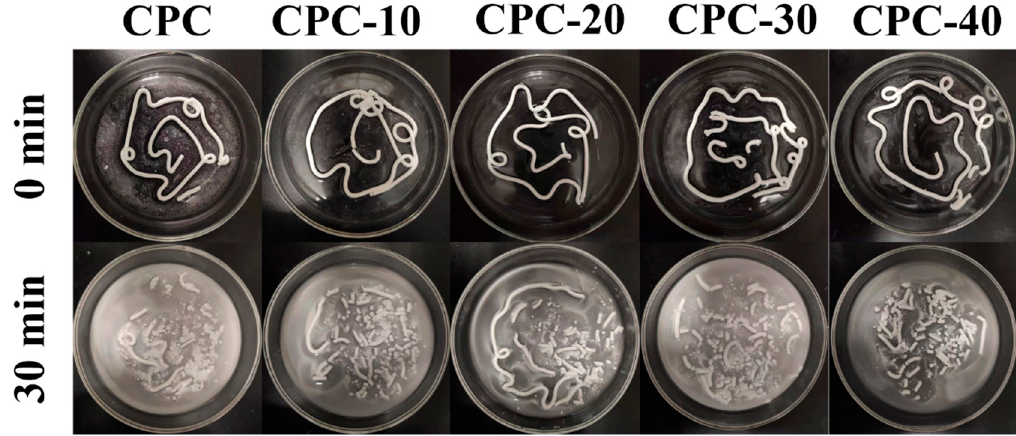
Figure 4. Optical images showing the anti-washout property of PLGA-PEG-PLGA/CPCs and control CPC. The pastes were injected into SBF solution at 37 °C and shaken for 0 min and 30 min.